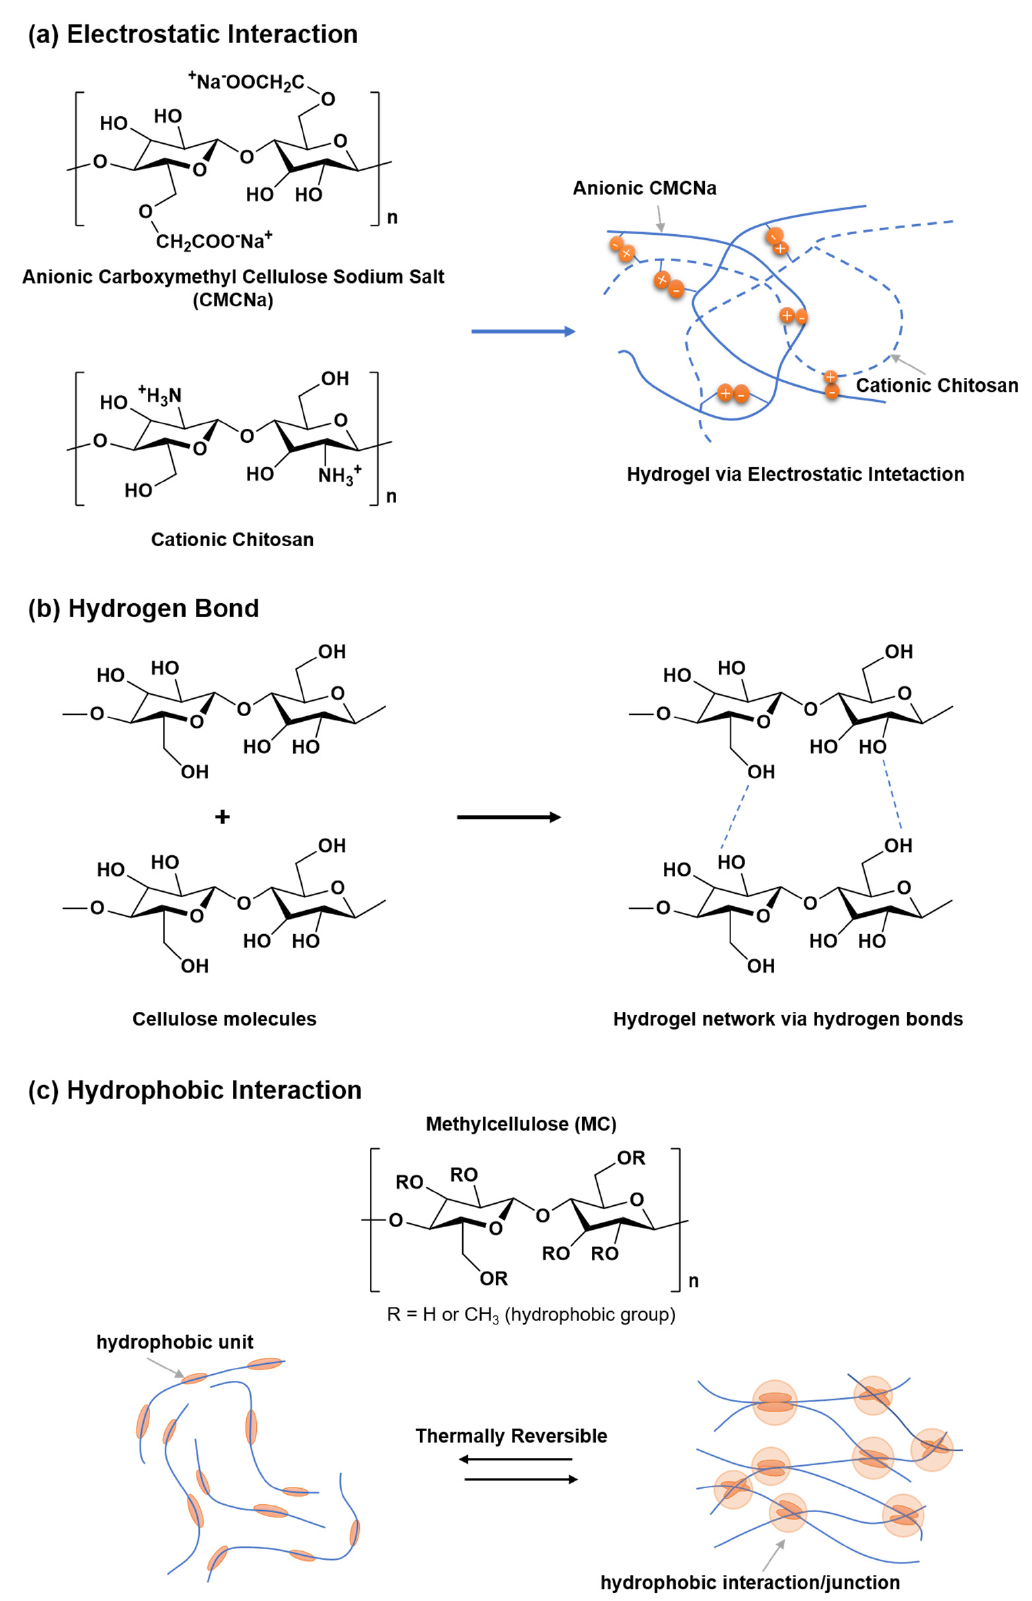
Figure 7. Crosslinking mechanism of physical hydrogels via ( a ) electrostatic interactions, ( b ) hydrogen bond interactions, and ( c ) hydrophobic interactions. Data reproduced from ref. [83] .